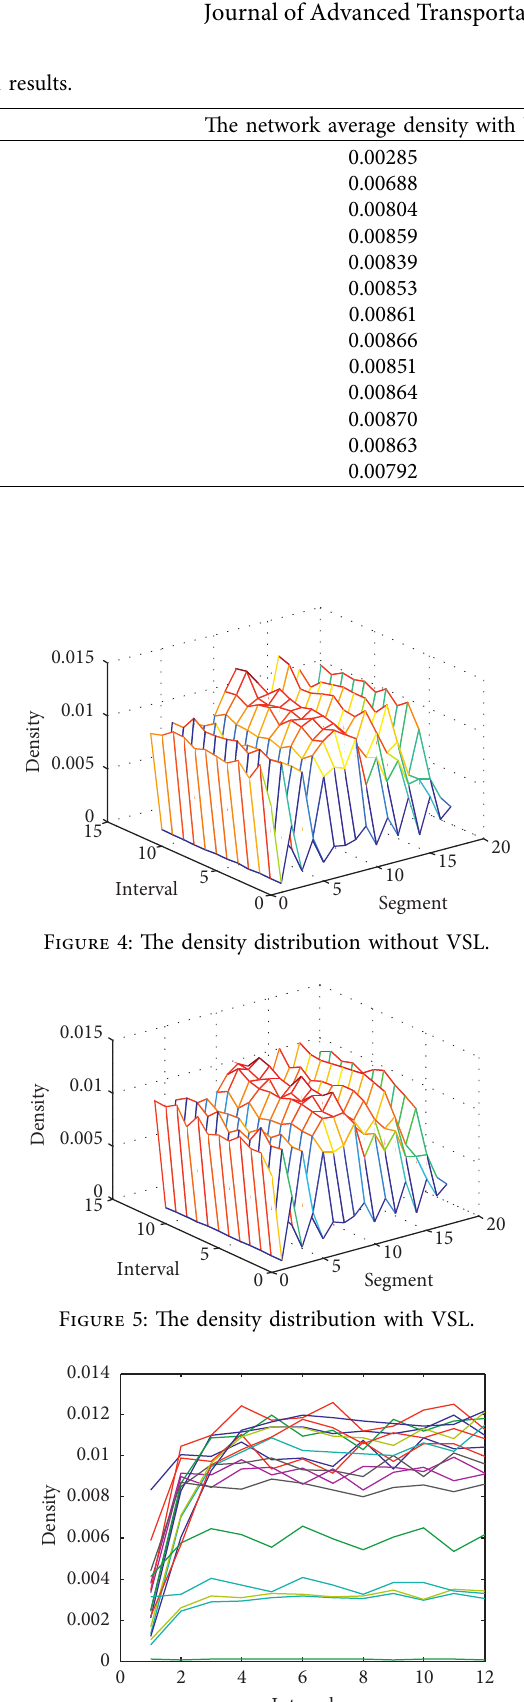
Figure 6: Two-dimensional density without